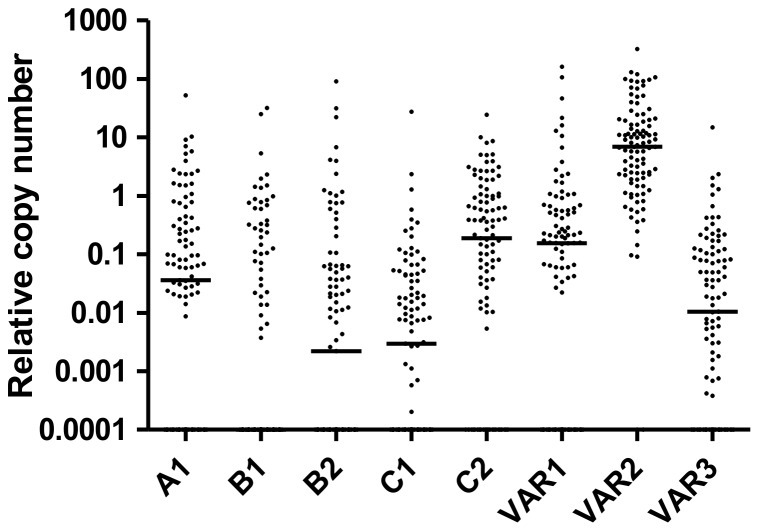
Transcription level of var genes were shown as relative copy number. Bars indicate the median of distribution.